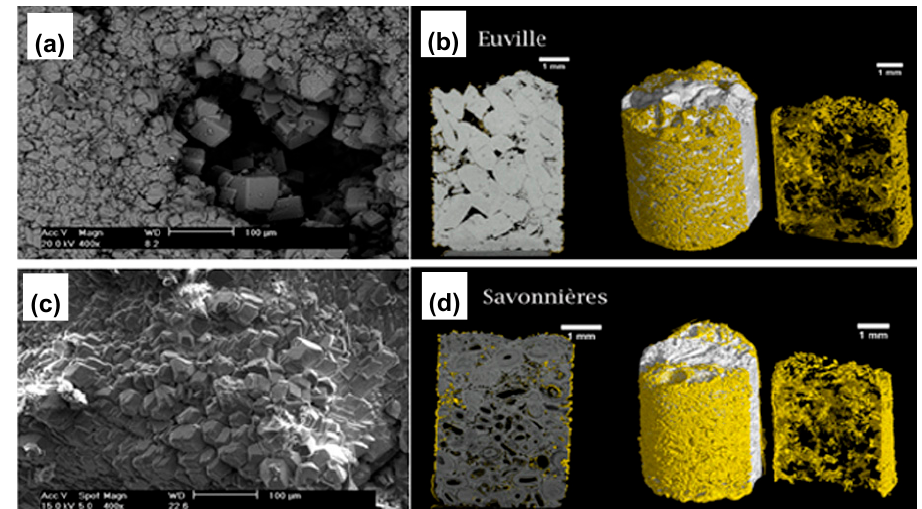
Figure 6. Scanning electron microscopy (SEM) images of MICP-treated limestone: ( a ) Aubigny and ( c ) Euville samples. 2D (left) and 3D (middle and right) microtomograph of MICP-treated limestone: ( b ) Euville and ( d ) Savoniers samples. Newly formed carbonate crystals are yellow. Adapted with permission from [73] 2011, American Society for Microbiology.